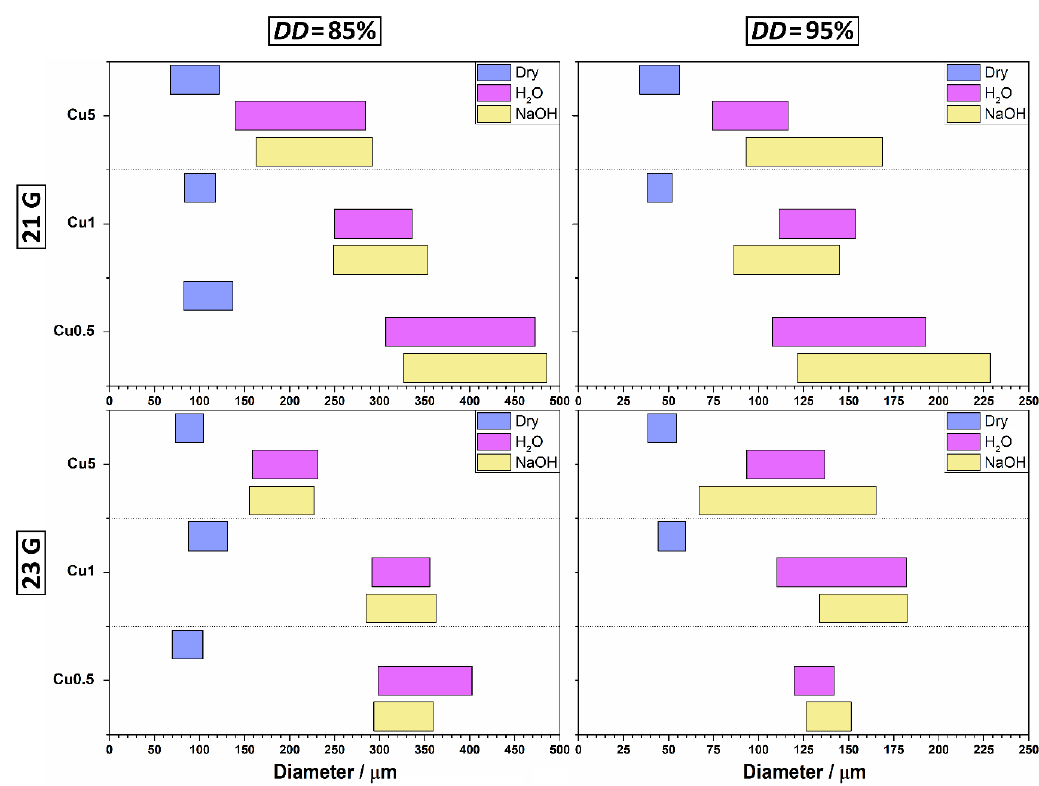
Figure 4. Estimated size of chitosan–Cu 2+ microspheres in 5 wt.% NaOH solution, distilled water and dried microspheres.